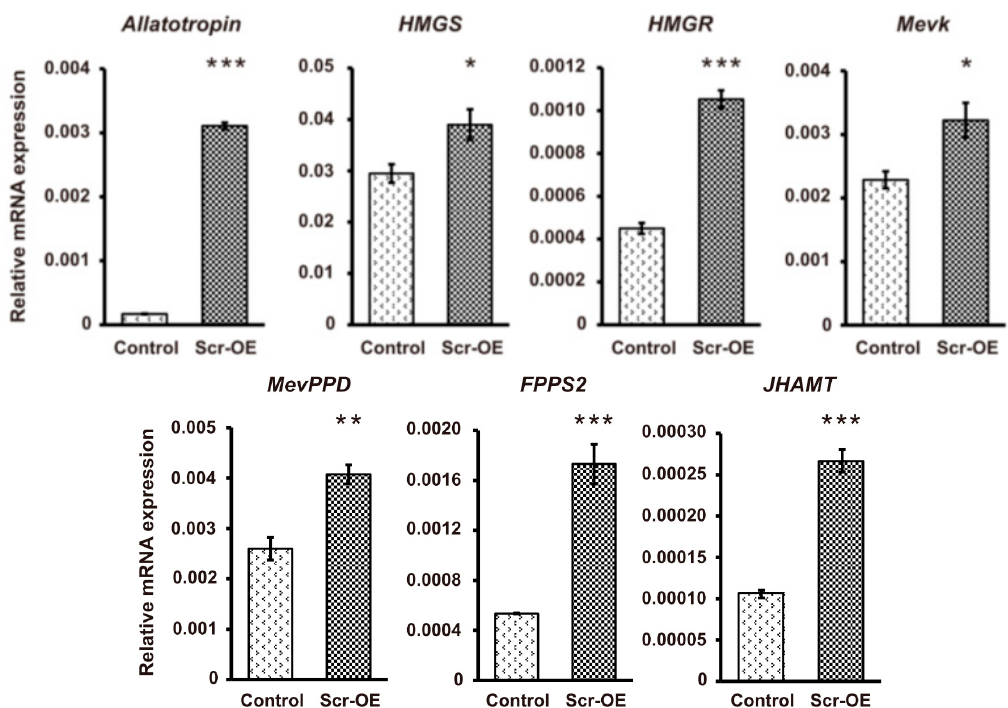
Figure 6. The effects of Scr overexpression on the transcription of genes involved in JH biosynthesis. The vector used to overexpress the silkworm Scr gene was transfected into BmE cells. The EGFP -overexpressing vector was used as a control. The cells were collected 72 h after transfection for qRT-PCR analysis. Among the genes involved in JH biosynthesis, the transcription of the Allatotropin gene and the genes that encode key enzymes, including HMGS , HMGR , MevK , MevPPD , FPPS2 , and JHAMT , were significantly induced after Scr overexpression. OE, overexpression. The error bars represent the mean ± S.E. ( n = 3). The significance of the difference between data sets was calculated using two-tailed Student’s t -test. * p < 0.05; ** p < 0.01; *** p < 0.001, compared with the control.